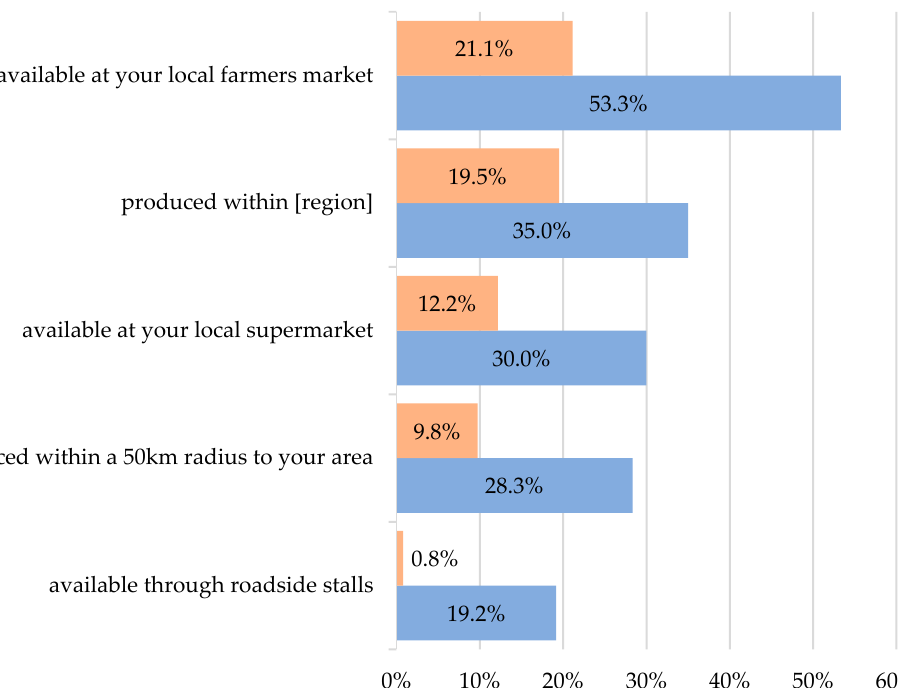
Figure 2. The percentage of respondents who agreed with each definition of regionally grown fresh fruits and vegetables in Tasmania (TAS) and South Western Australia (SWA) (Respondents could select more than one response).